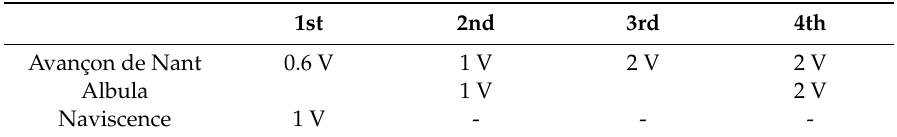
Table 6. A max required for the 0.1 V threshold to be exceeded at one, two, three, and four plates of distance in all three investigated measuring stations.